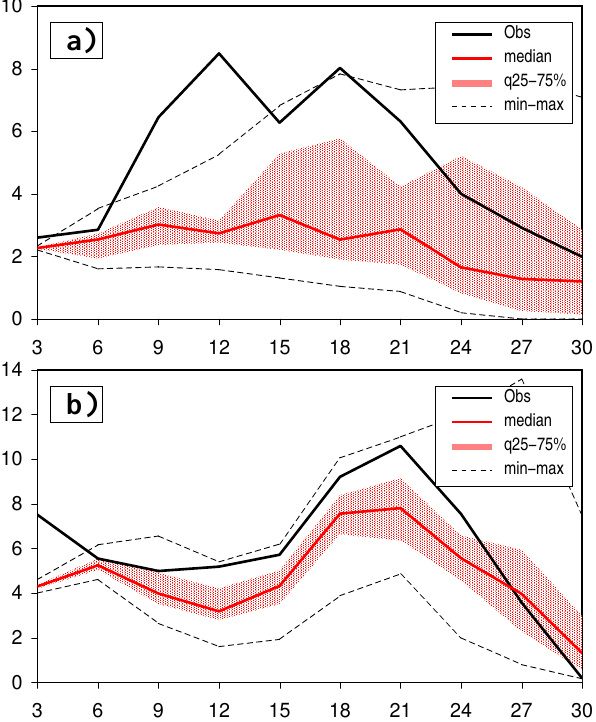
Fig. 9. Time series of the 3-h surface precipitation (mm) for REF and for the Var (a) and Gard (b) cases, averaged over the subdomain seen in Figs. 6 and 8, respectively. Interquartile ranges (25%– 75%), minimum, maximum and medians are shown. Initial times of the forecasts are 00:00UTC of 15 June 2010 for the Var case and 00:00UTC of 7 September 2010 for the Gard case, respectively.